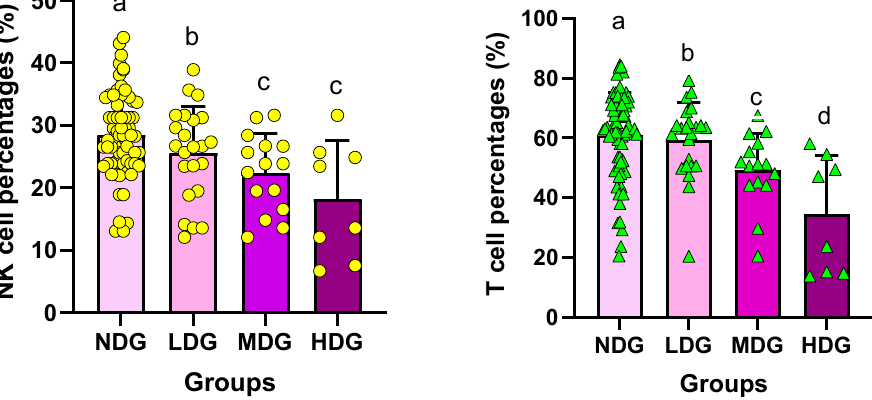
Figure 5. Differences of NK cells and T cells between the groups. Symbols a , b , c , and d represent post hoc results from Bonferroni test.